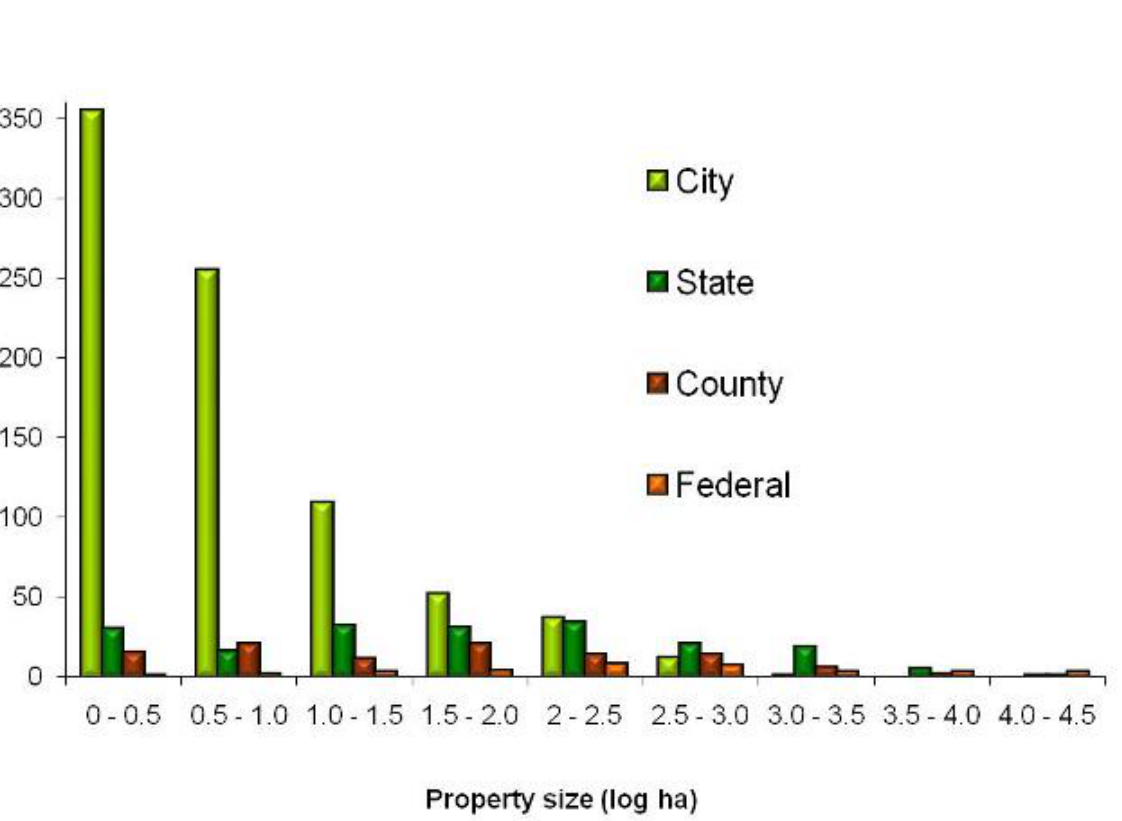
Fig. 5 . Size distribution of properties held by city, county, federal, and state governments. These landowners held few conservation easements in the San Francisco Bay